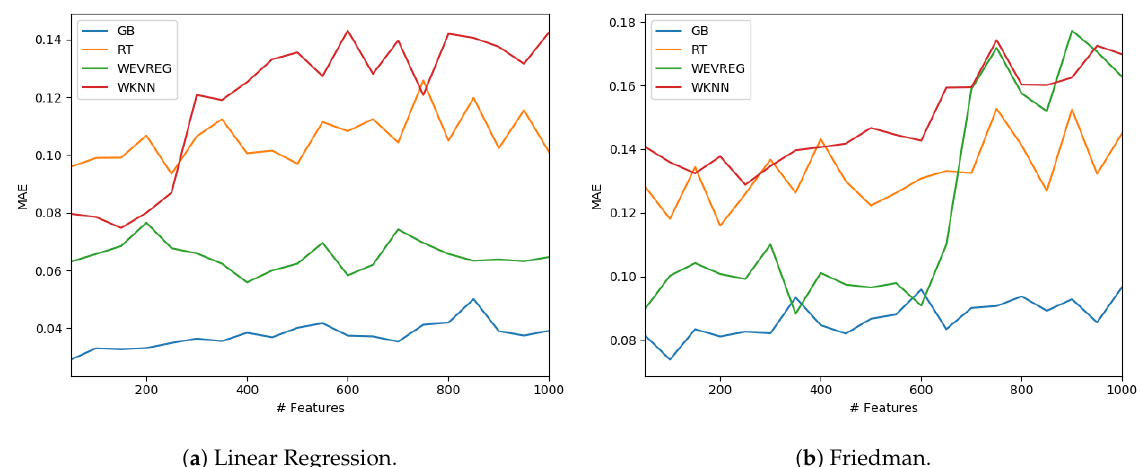
Figure 4. Model performance with different number of